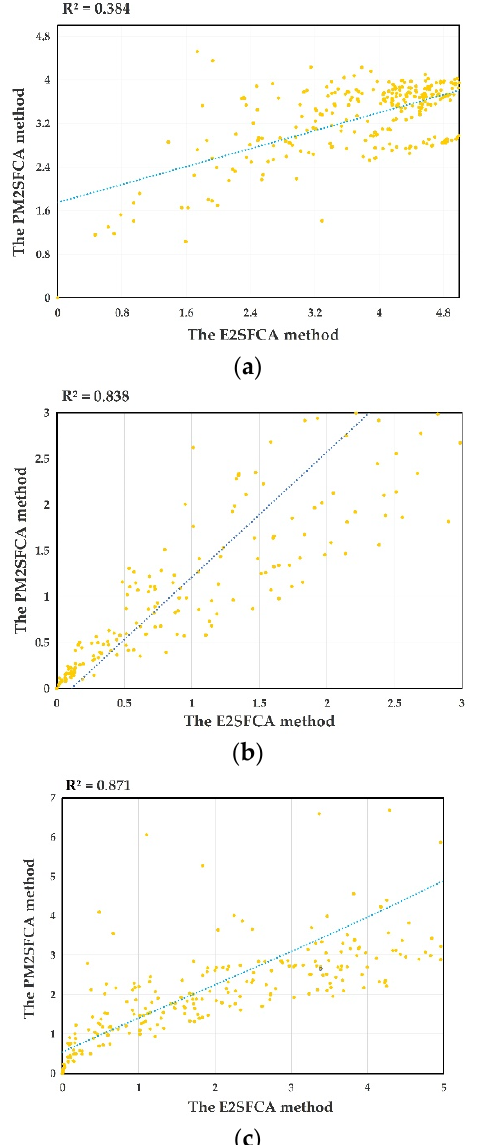
Figure 13. Scatter plot among the accessibility values by the PM2SFCA and E2SFCA methods (( a ) biking mode; ( b ) driving mode; and ( c ) public transport mode).